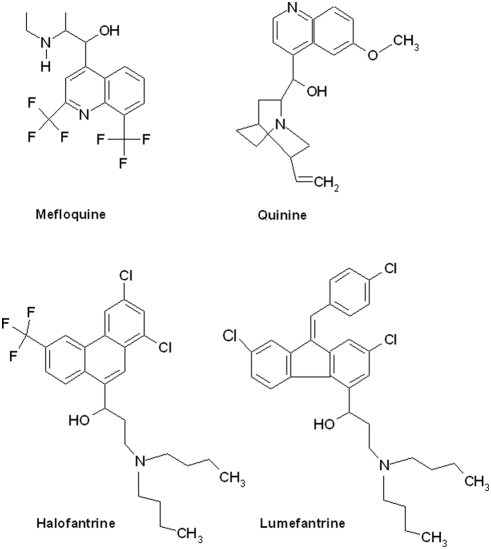
Chemical structures of mefloquine, quinine, halofantrine, and lumefantrine.